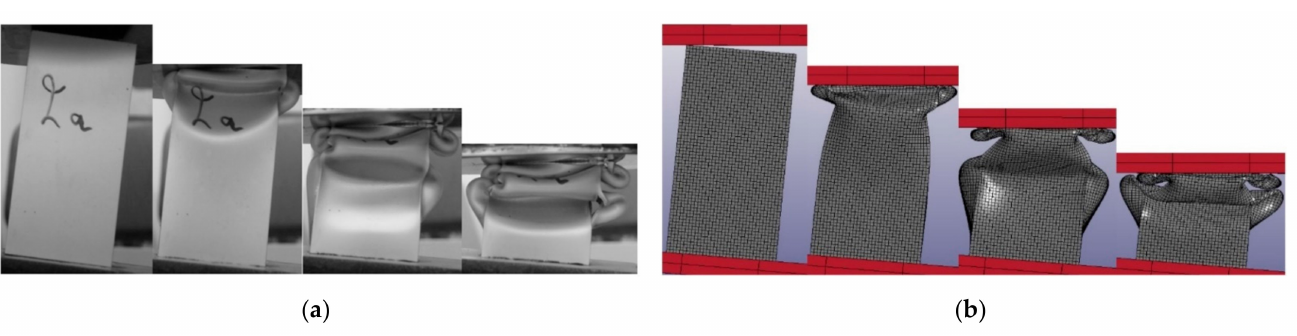
Figure 9. Plastic deformation progress of 0 ◦ crushing angle for axial impact. ( a ) experiment; ( b ) simulation.